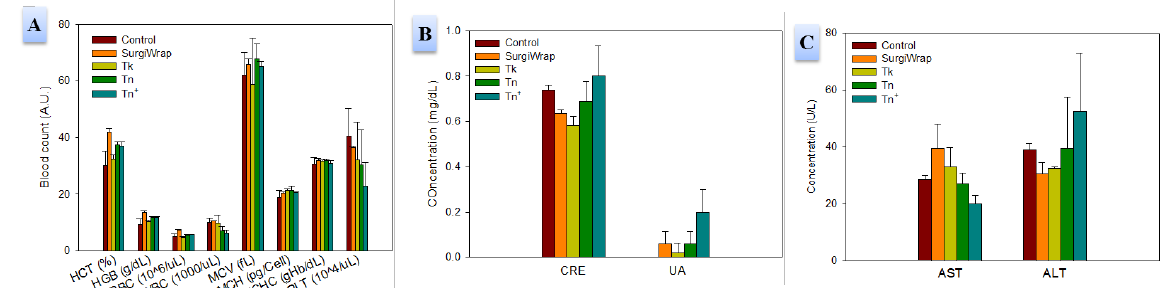
Figure 13. The blood testing results at one week postoperatively from complete blood count ( A ), renal ( B ), and liver ( C ) functions assessments. HCT, hematocrit; HGB, hemoglobin; RBC, red blood cell; WBC, white blood cell; MCV, mean corpuscular volume; MCH, mean corpuscular hemoglobin; MCHC: mean corpuscular hemoglobin concentration; PLT, platelet; CRE, creatinine; UA, uric acid; AST, aspartate aminotransferase; ALT, alanine aminotransferase. The data are expressed as mean ± standard deviation ( n = 8).